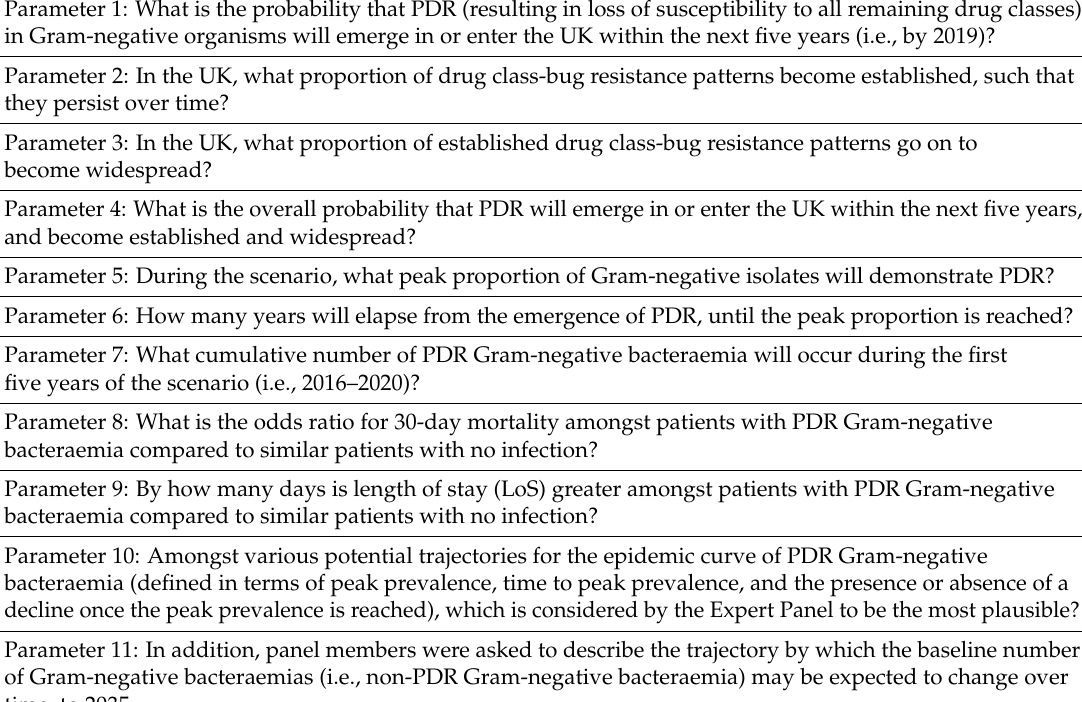
Table 5. Parameters elicited from the